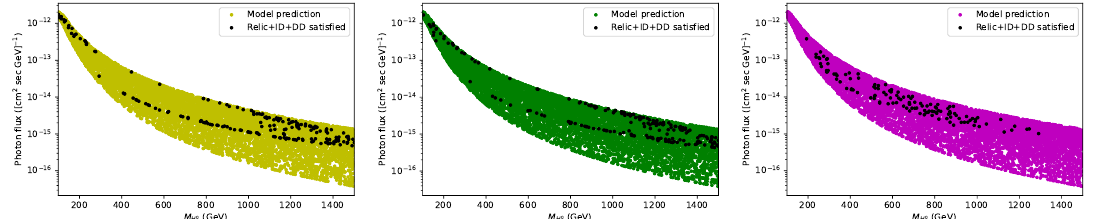
Figure 2 . Indirect detection restrictions case with the photon flux versus dark matter mass for Case (i) — degenerate scotino mass scenario (Left), Case (ii) — small mass splitting (Middle), and Case (iii) — large mass splitting (Right). All points satisfy constraints from Fermi-LAT [34], while the black dots are also consistent with relic density + DD restrictions imposed by PICO-60 as well as XENON1T experiments (figure